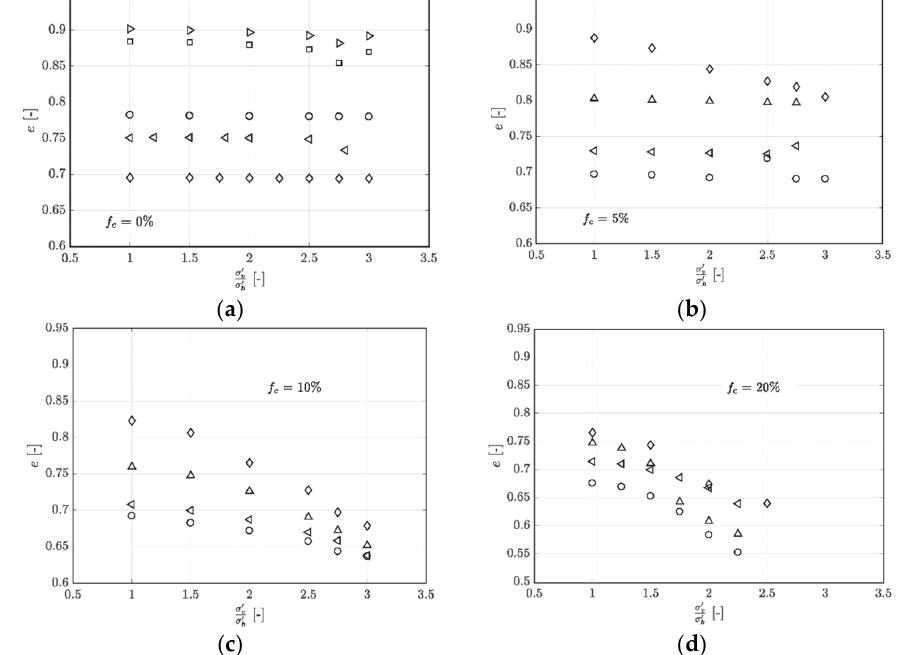
Figure 6. Void ratio e vs. anisotropic stress for ( a ) clean Hostun sand and sand mixed with ( b ) 5%, ( c ) 10% and ( d ) 20% fines, respectively.